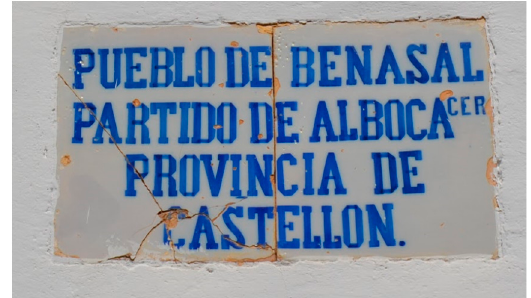
Figure 5. Benasal: Spanish-only historical sign .